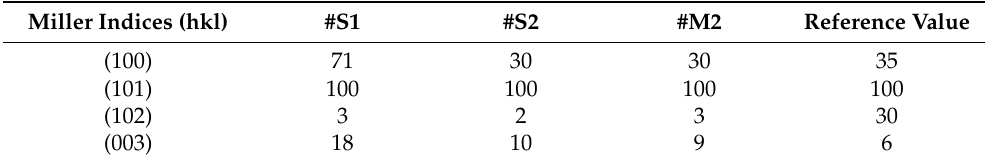
Table 3. Relative intensity of Gd 2 O 2 S peaks in the angular range 2 θ = 24 ◦ –42 ◦ . Reference values from ICDD file n. 26-1422 are reported for